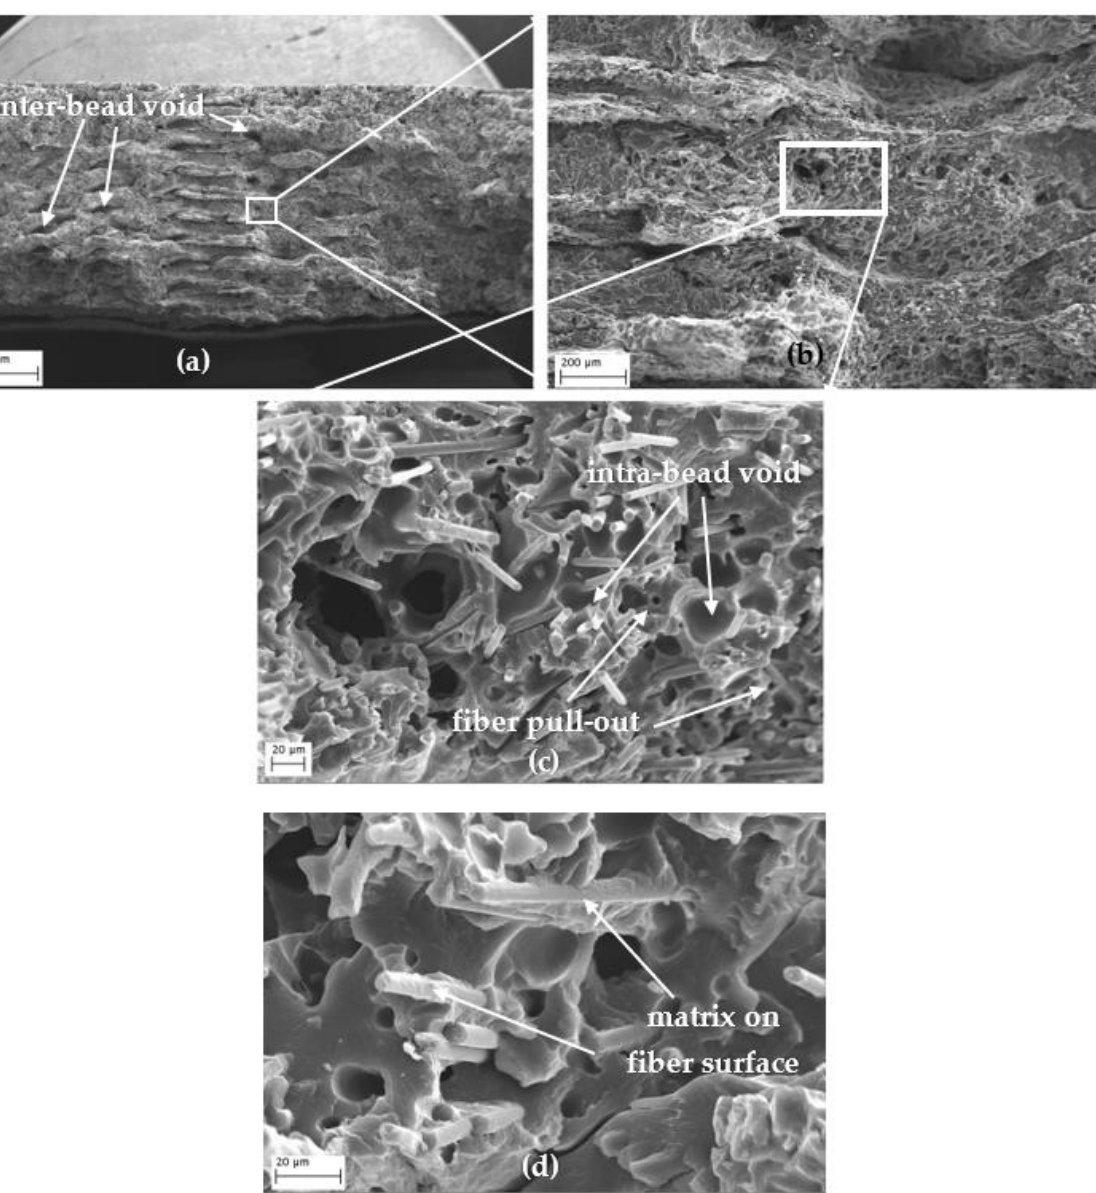
Figure 11. An SEM image of the fracture surface of the CF-reinforced tensile samples showing fiber pull-out, inter, and inter-bead void structures. ( a – c ) The zoomed micrograph series and ( d ) the matrix on the fiber surface.